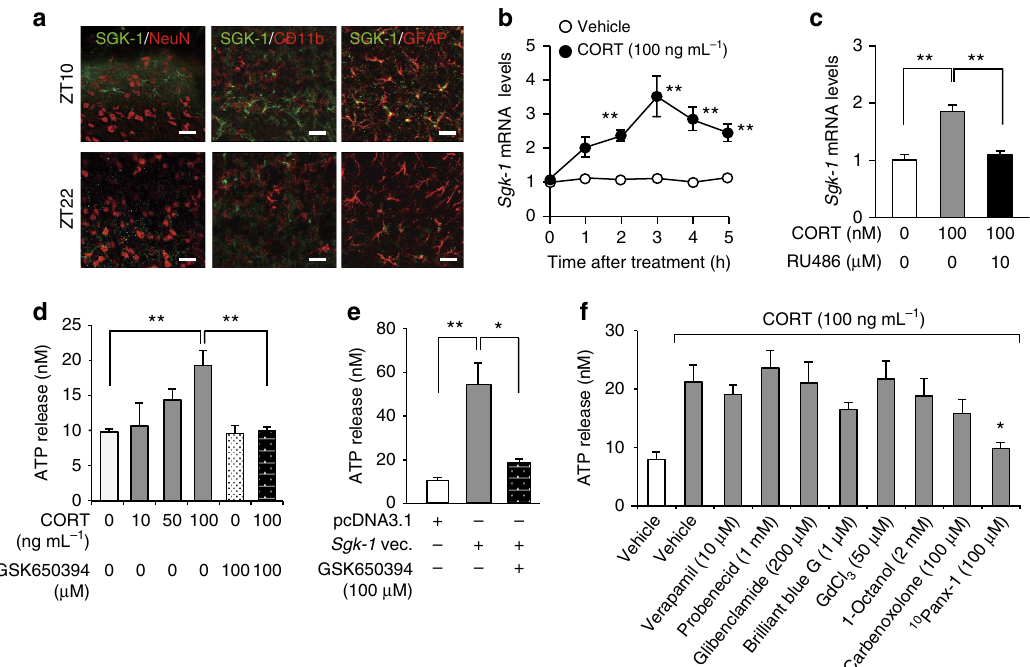
Figure 5 | The expression of SGK-1 enhances ATP release from astrocytes. ( a ) Double immunofluorescence labelling of SGK-1 with NeuN, a marker of neurons; CD11b, a marker of microglia; and GFAP, a marker of astrocytes in the ipsilateral spinal slices of male sham þ PSL mice at ZT10 and ZT22. SGK-1- positive cells are double-labelled (yellow) with GFAP at ZT10. This experiment was performed on day 7 after nerve injury. Scale bar, 10 m m. Data are representative of five independent experiments. ( b ) Time course of the CORT-induced expression of Sgk-1 mRNA in primary cultures of astrocytes (means ± s.e.m.; n ¼ 5). ** P o 0.01 significantly different from the basal level ( F 11,48 ¼ 25.460, P o 0.001, ANOVA with Tukey–Kramer’s PHT). ( c )